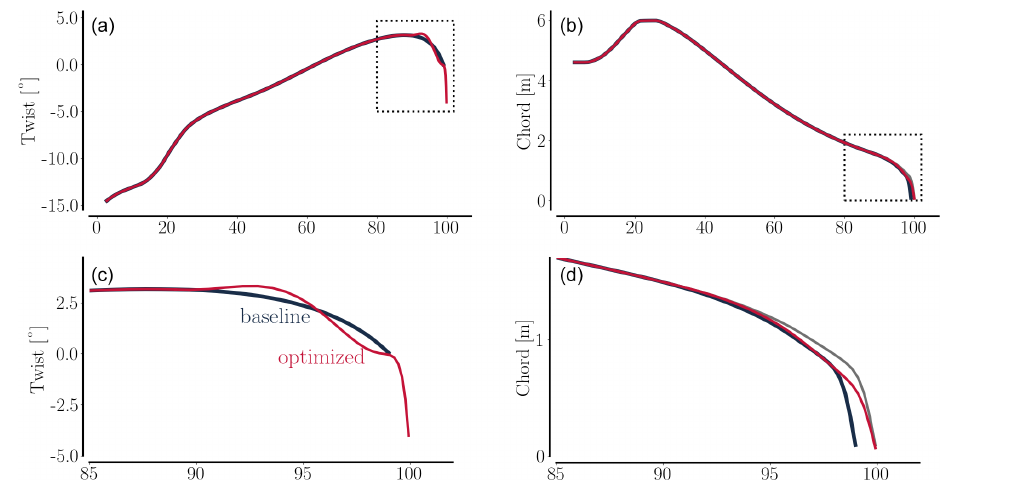
Figure 13. Planform distribution for twist and chord for the shape optimization result from grid level L1. Gray chord distribution signifies a stretched blade without any chord scaling in order to better discern where the reduced chord is taking place on the stretched